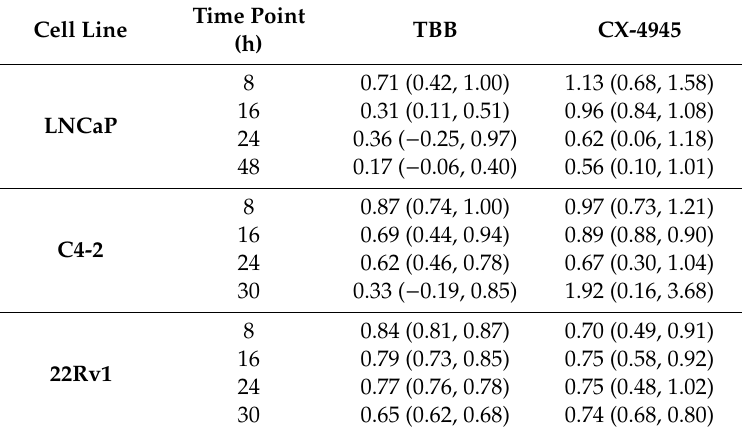
Table 3. Fold-change in protein level of AR after CK2